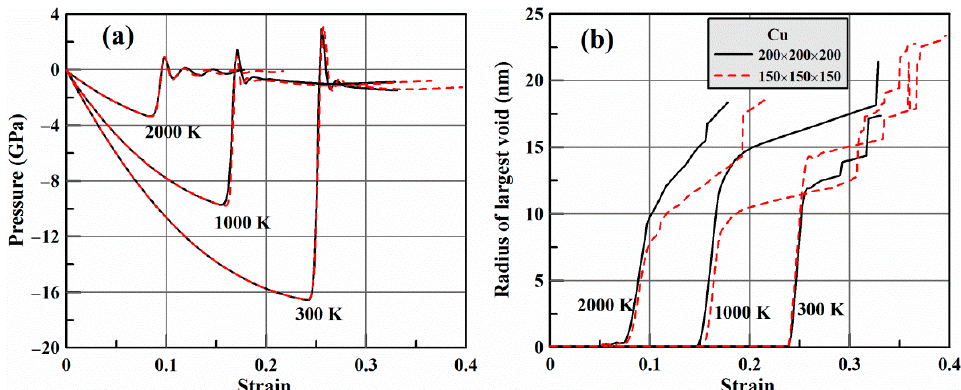
Figure 3. Data of MD simulations with the moderate MD system (13.5 million atoms) and the large MD system (32 million atoms) at three considered test temperatures: ( a ) Evolution of pressure with strain and ( b ) evolution of the radius of the largest void in the system.